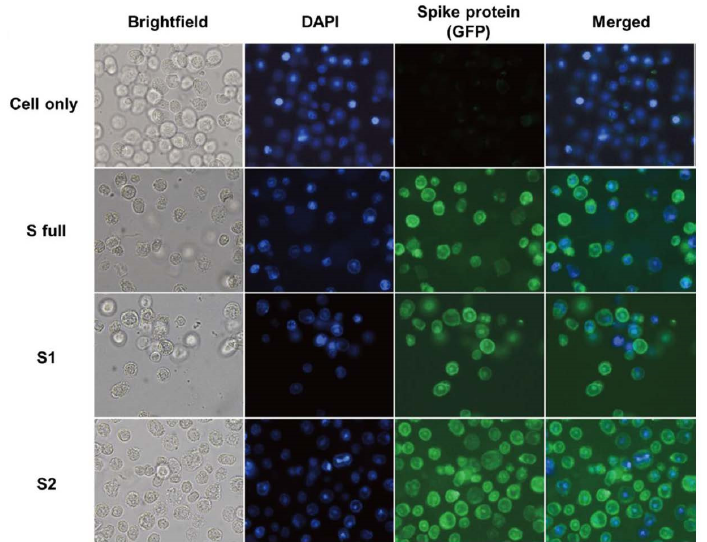
Figure 3. Confirming recombinant baculovirus construction. Polyclonal antibodies were raised against the S RBD and S2 antigens. The two antibodies were used to detect successful transfection of bacmid DNAs into Sf9 cells via immunocytochemistry. The S RBD antibodies were used to detect protein expression for the S full and S1 rBVs, whereas S2 antibodies were specifically used for the S2 rBV.